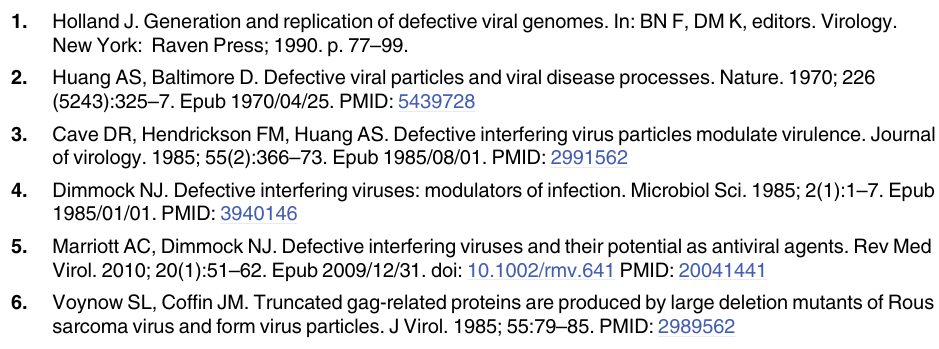
S7 Fig. Changes in the homeostatic shutdown function have only weak effects on the steady-state cell division rate ( h ). (A,C) The dependence of the maximum cell division rate eq ), relative target cell level ( T) , and mean TIP copy number per cell ( q ) on the equilibrium ( h 0 (see Eqs. 51 – 58 in S1 Text). (B,D) Two forms of the homeostatic shutdown division rate h eq on h is dominated by the asymptotic behavior of T as q function. The dependence of h eq 0 approaches 1 (i.e., as the TIP copy number increases), and is robust to the shape of homeostatic = 10; all other parameters are found in shutdown function f ( x ). Parameters: η = 0.5, P = 12, R 00